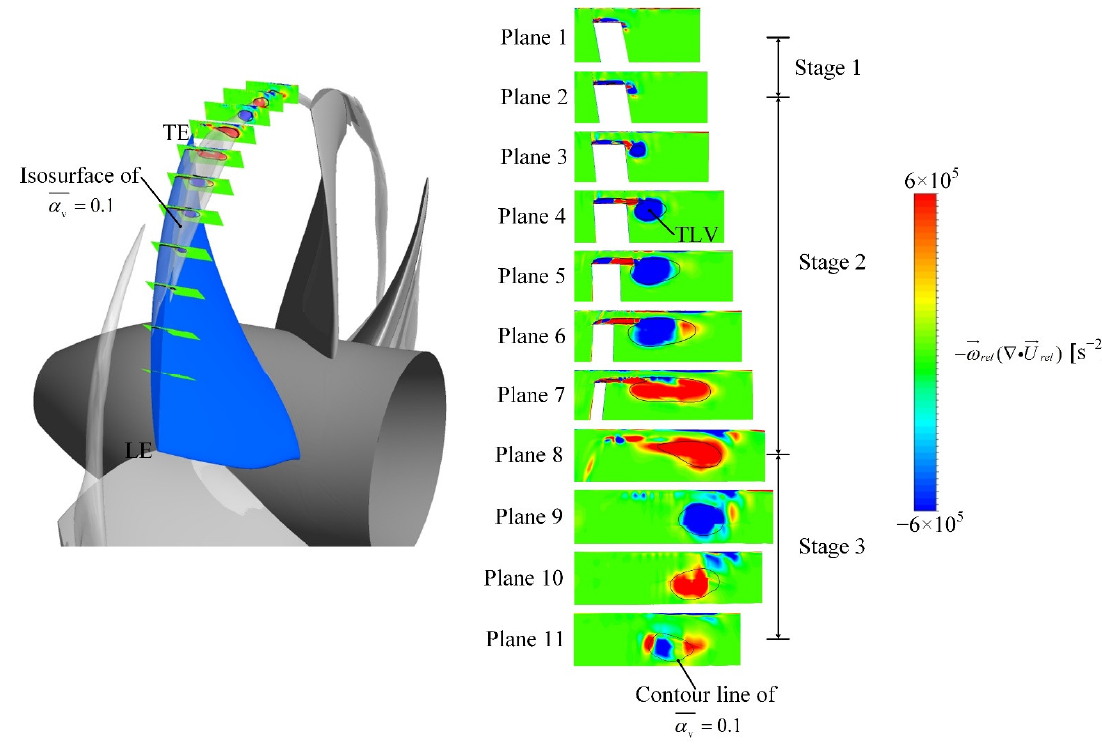
Energies 2022 , 15 , x FOR PEER REVIEW Figure 9. Vortex-dilatation term. Figure 9. Vortex-dilatation term.